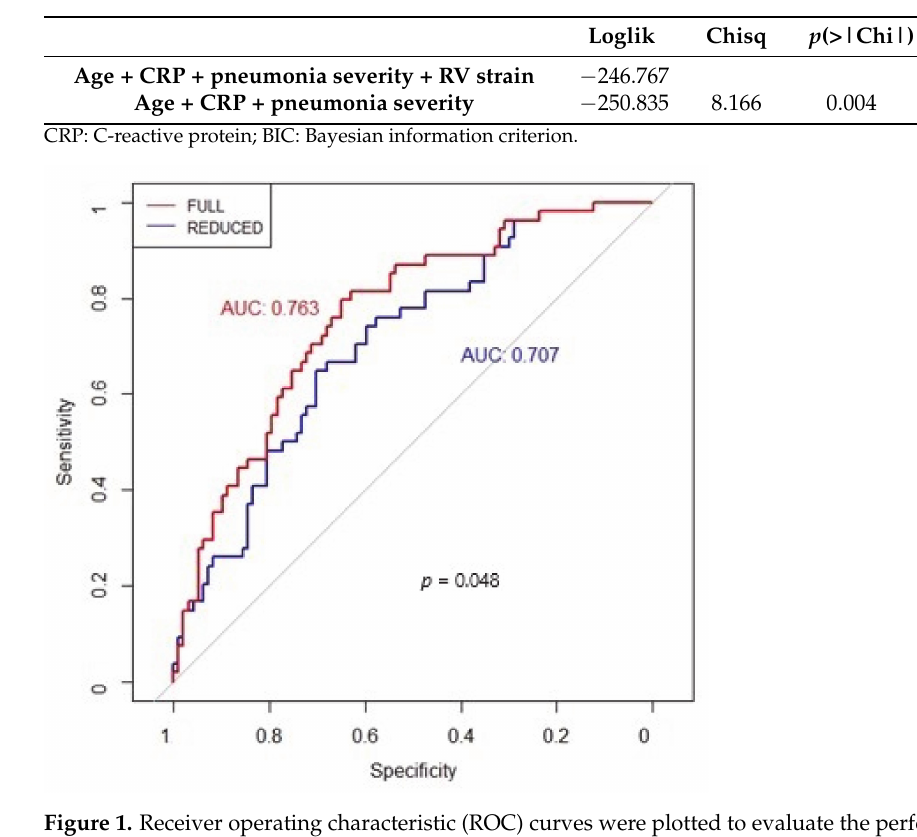
Table 4. Prognostic value over chest CT scan.